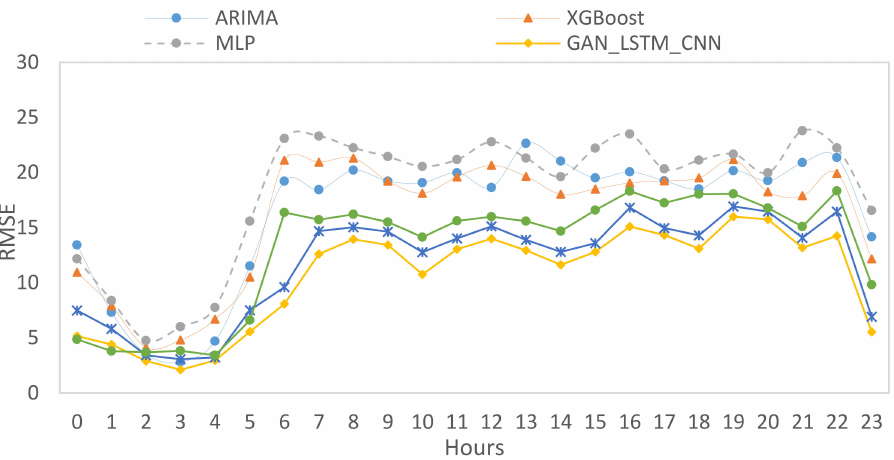
Figure 19. RMSE Comparison Results with hours ranged from 0–23 with increasing values from 6:00 to 22:00 and all deep learning methods achieved better results.